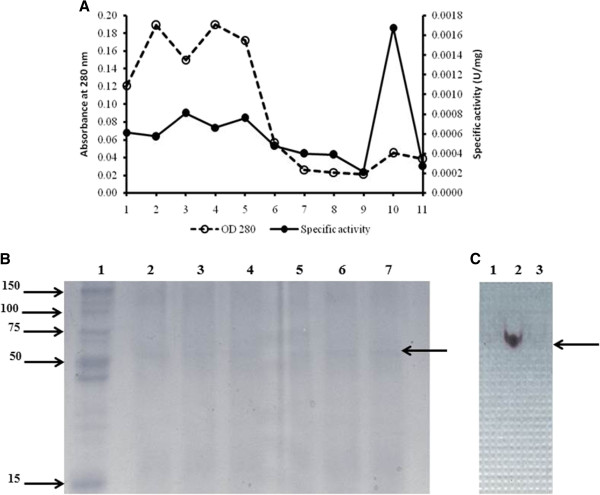
Enrichment profile for the rAciHBGase II–(His)6 protein by Histrap affinity column. (A) Elution profile from the Histrap column. The washed fractions contained a high content of protein while eluted fraction # 10 presented the highest specific activity of HBGase II. (B) SDS-PAGE resolved and coomassie blue stained protein profile of selected fractions from the Histrap column elution. Lane 1: standard protein marker, lanes 2-6: contained 1 μg of protein in fractions # 2, 4, 6, 8 and 10, respectively. Lane 7 is a duplication of lane 6. (C) Glucosidase activity stain of the renatured SDS-PAGE resolved protein samples (Zymograph). Lanes 1-3, fractions # 9-11, respectively. Arrows in (B) and (C) indicate the ~ 73 kDa band.